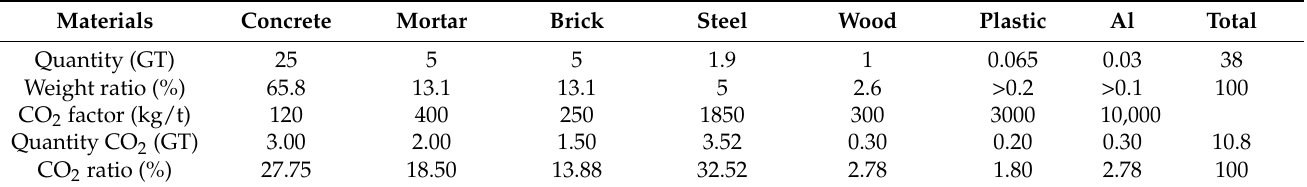
Table 1. Global quantity and equivalent carbon embodiment of the primary construction materials [6–8].